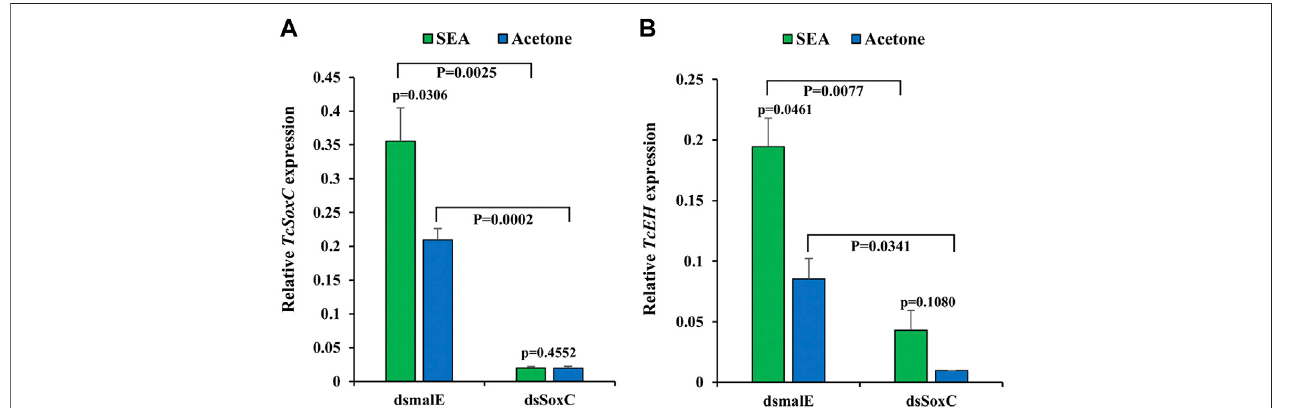
FIGURE1| SoxC isrequiredfor20Einductionof EH in T.castaneum .Newlymolted fi nalinstarlarvaewereinjectedwith400 ngofds SoxC and2 µLofSEAsolution (dissolved in acetone) was added on the dorsal side abdomen of insects upon entry into quiescent stage and emergence of compound eyes. The control group was treated with acetone. 12 h after treatment, insect total RNA was isolated and quanti fi ed with RT-qPCR. (A) The expression of TcSoxC increased signi fi cantly in larvae from the control group treated with SEA, but this increase was blocked larvae treated with both ds SoxC and SEA. (B) The expression of TcEH increased signi fi cantlyinlarvae fromthecontrolgrouptreated withSEA but thisincreasewasblocked larvaetreated withboth ds SoxC andSEA.Means ±SEofthree independent experiments are shown ( p values come from t tests